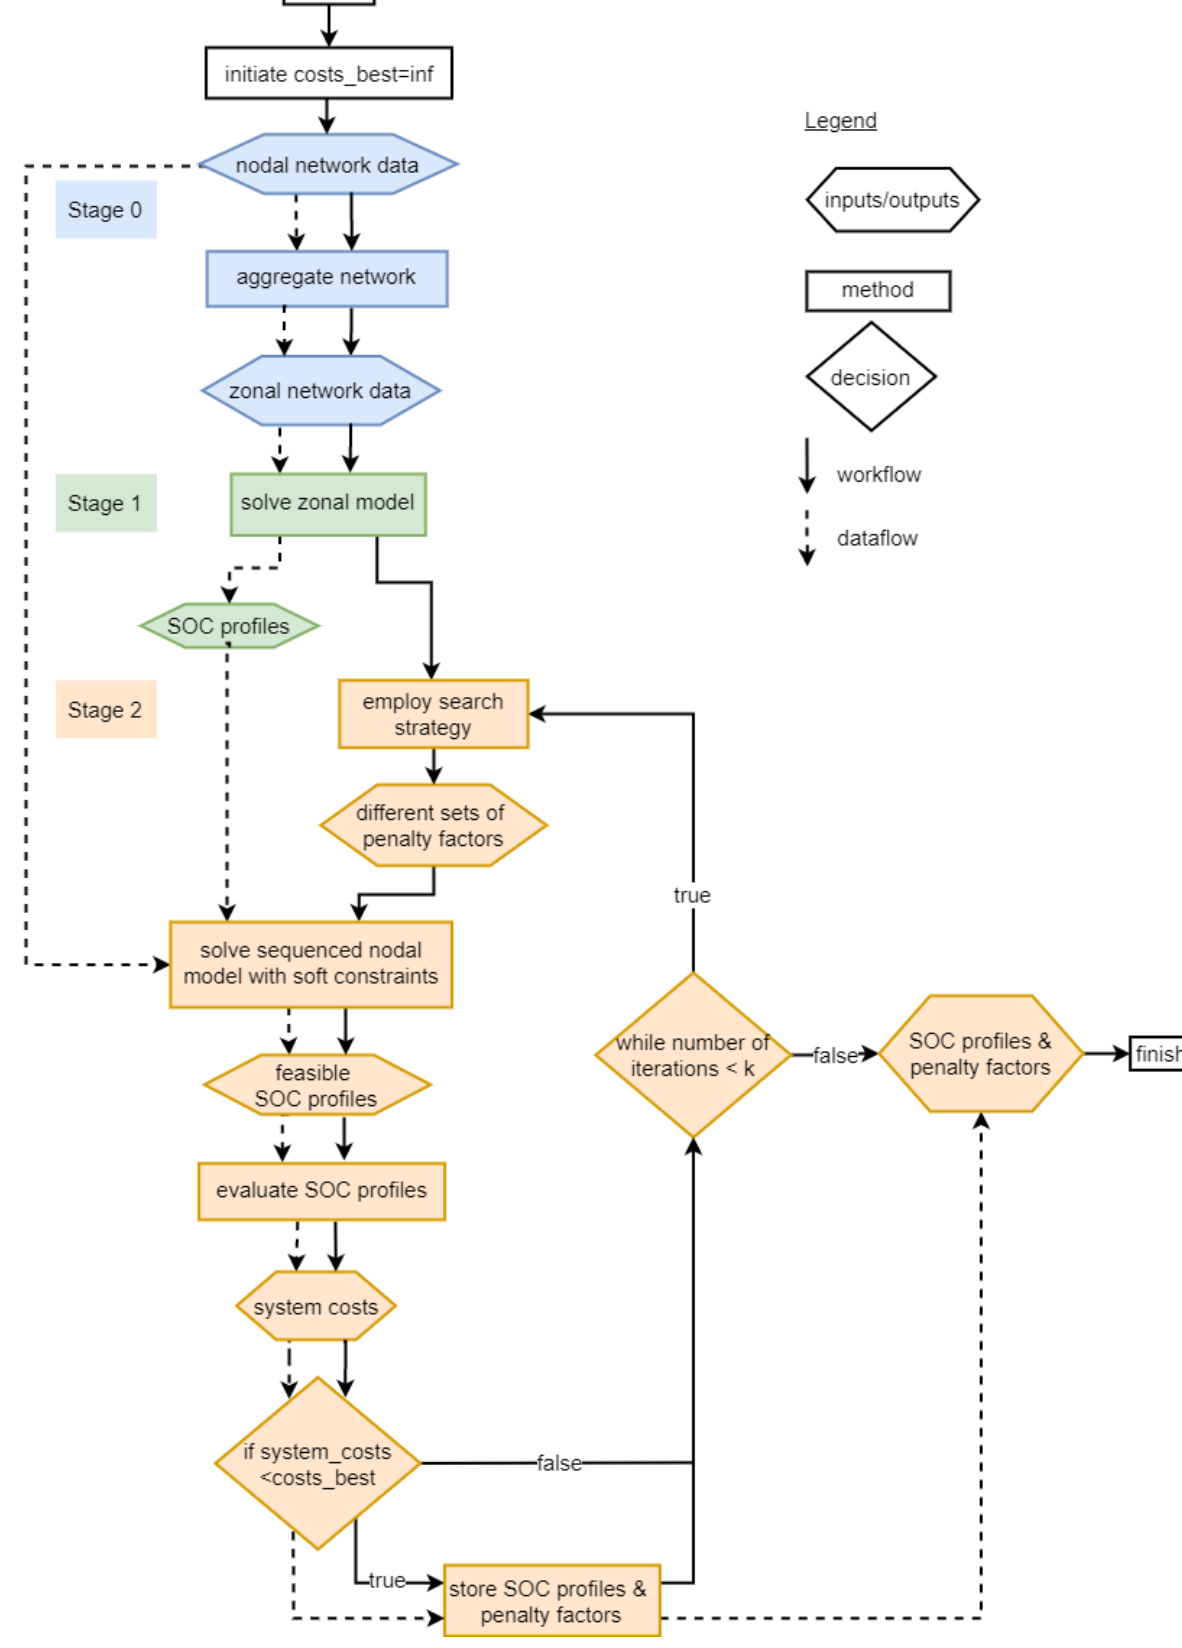
Figure 1. Stage-wise methodology to obtain SOC profiles for large-scale nodal